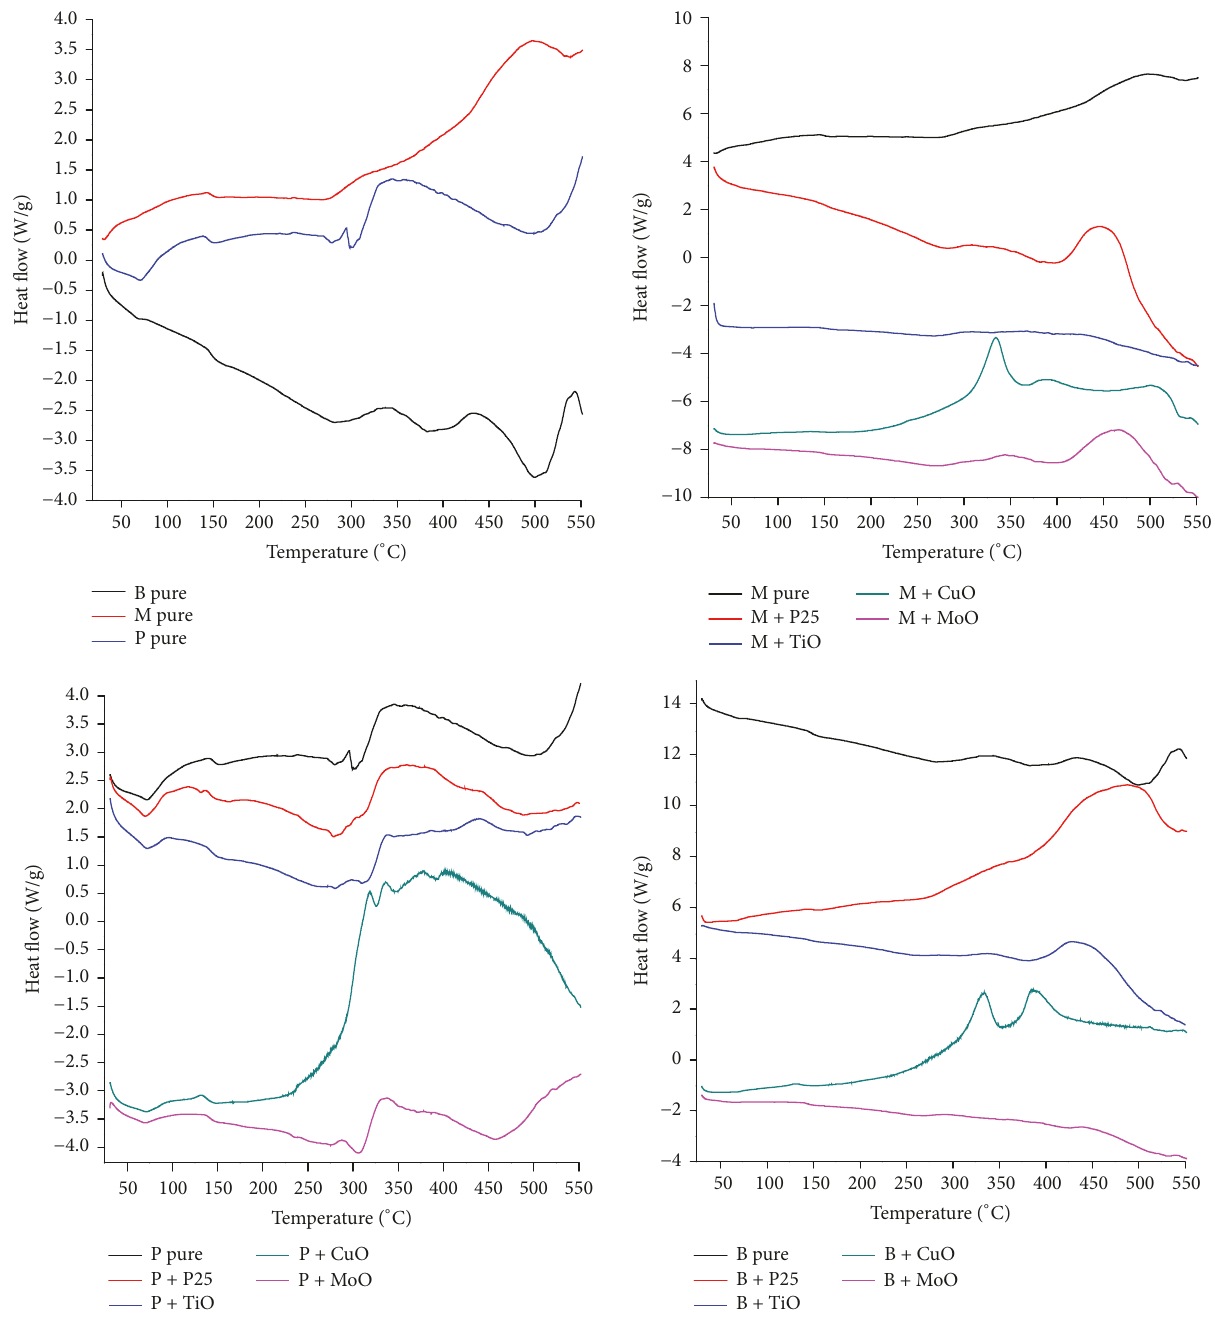
Figure 6: DSC phase diagram of samples in pure state and also doped with metal oxides